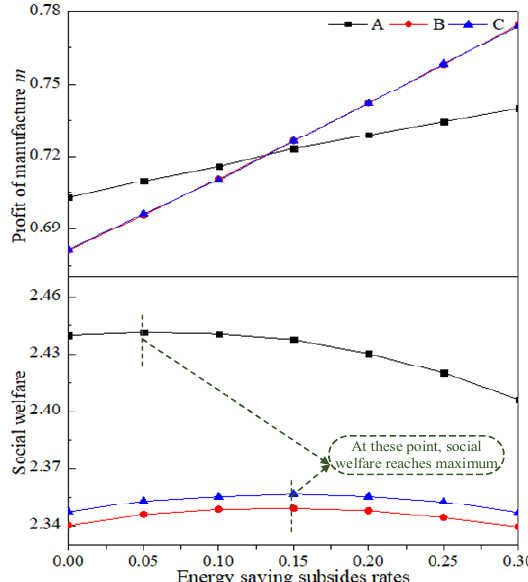
Figure 6. The SCNE results of manufacturer m ’s profit and social welfare in different scenarios.